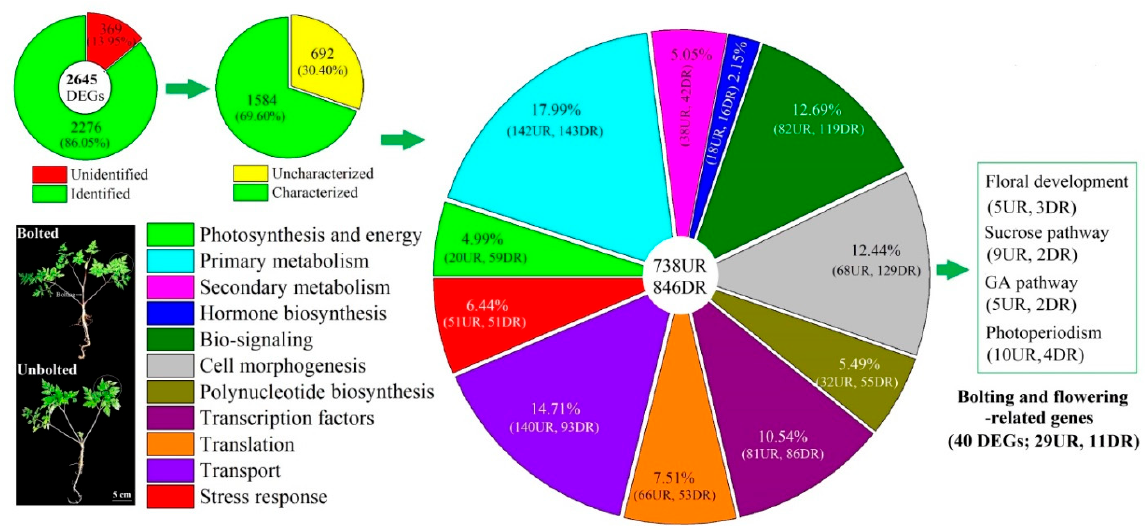
Figure 1. Distribution and classification of differentially expressed genes (DEGs) in bolted versus unbolted A. sinensis (UR, up-regulation; DR,